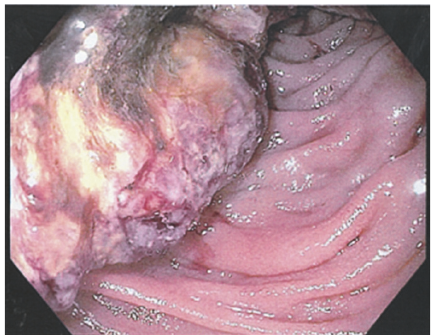
Figure 2: Duodenal mass, metastatic seminoma (H&E stain, mag- nification × 40).